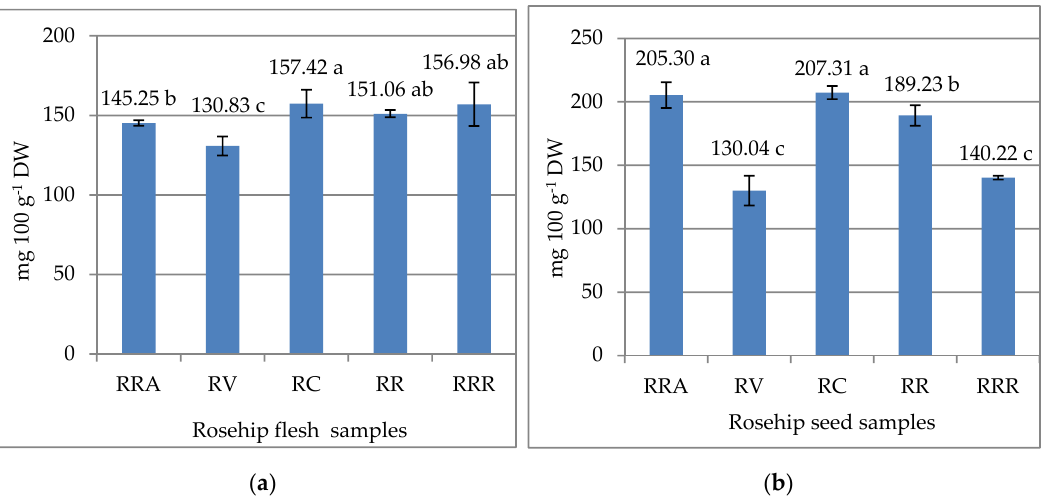
Figure 2. Total polyphenols content (mg 100 g − 1 DW) of different organic rosehip flesh ( a ) and seed ( b ) samples species. Different small letters represent significant differences between flesh samples and seed samples species, respectively ( p < 0.05). RRA: Rosa rugosa ‘Alba’; RC: Rosa canina ; RR: Rosa rugosa ; RRR: Rosa rugosa ‘Rubra’; RV: Rosa villosa.